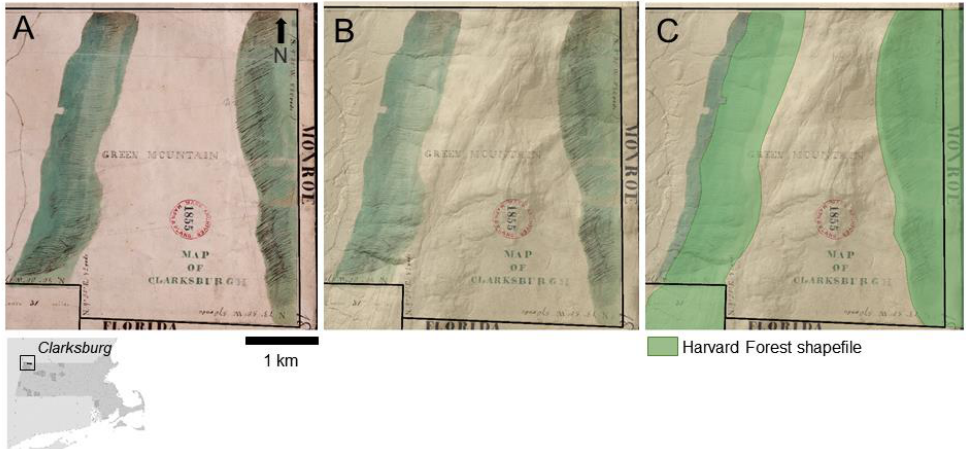
Figure 9. Panels ( A ) through ( C ) show the same extent of the eastern portion of Clarksburg, Massachusetts: ( A ) is the archival 1830 map (Public Domain, [80]) showing forest covering mountainous areas, ( B ) shows that map georeferenced and overlaid with 30% transparency on a LiDAR DEM, and ( C ) shows (B) plus the current extent of digitized forest cover from the Harvard Forest dataset which was digitized from the same map in the early 2000s. Map projection is NAD 1983 UTM Zone 18N.